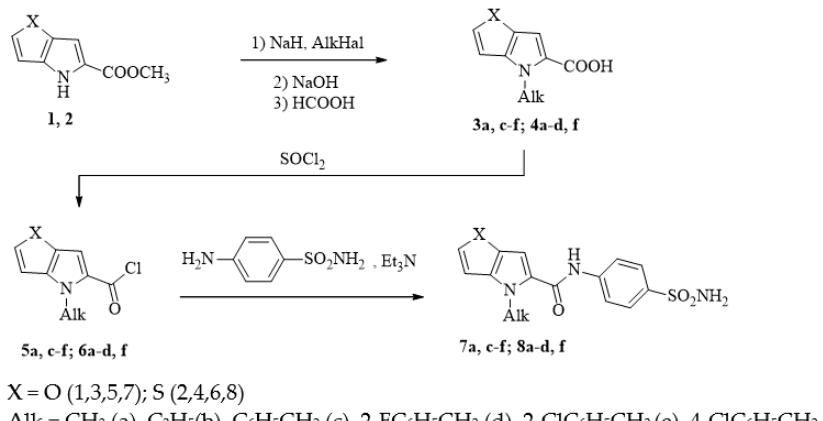
Scheme 1. Synthesis of furo[3,2- b ]pyrrole and thieno[3,2- b ]pyrrole derivatives.